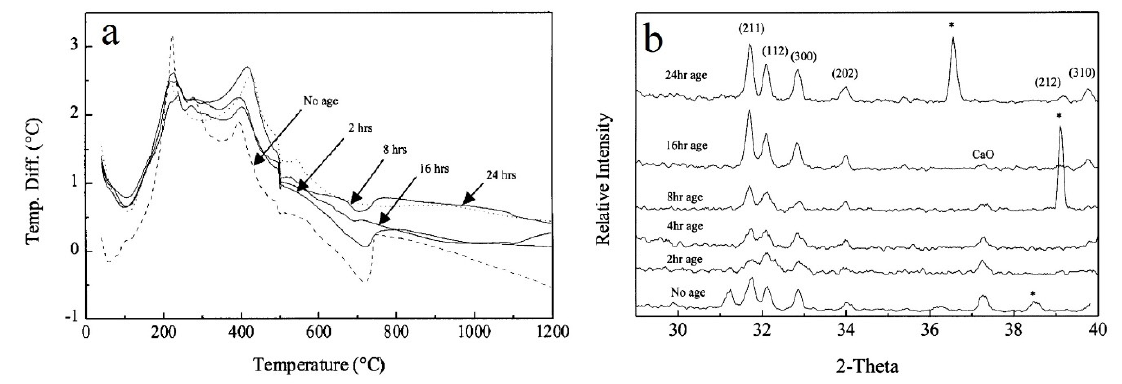
Figure 2. ( a ): DTA and ( b ): XRD for HAp coating aged up to 24 h [66], reprinted with permission from Elsevier.